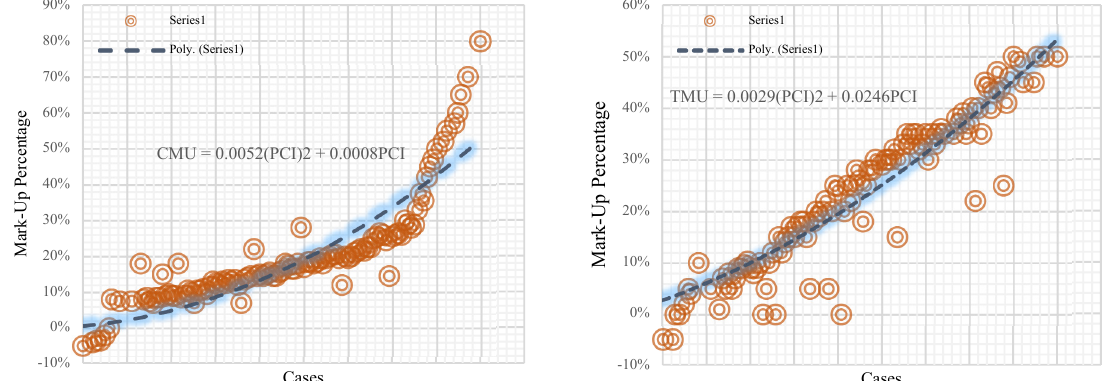
Figure 4. Cost ( left ) and time ( right ) mark-up data used for curve fitting and for developing the primary model. Table 7. Relation between the PCI and CMU based on data from 111 projects.